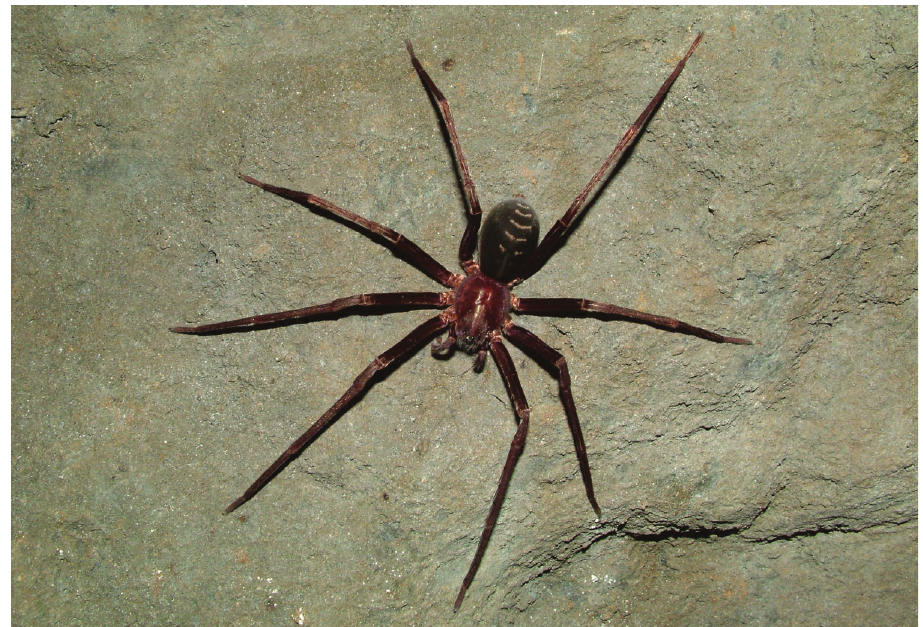
Figure 4. Ctenus fasciatus (Arachnida: Araneae), a common troglophile in caves from southeastern Brazil (Photo: Renata